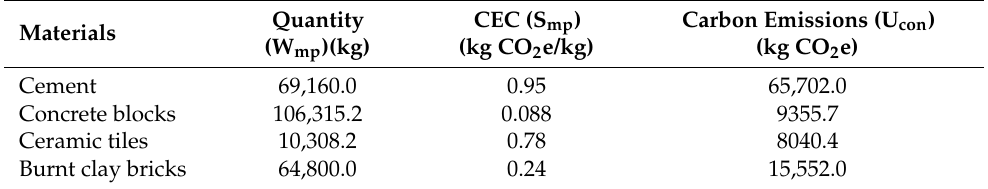
Table 7. Carbon emissions of construction